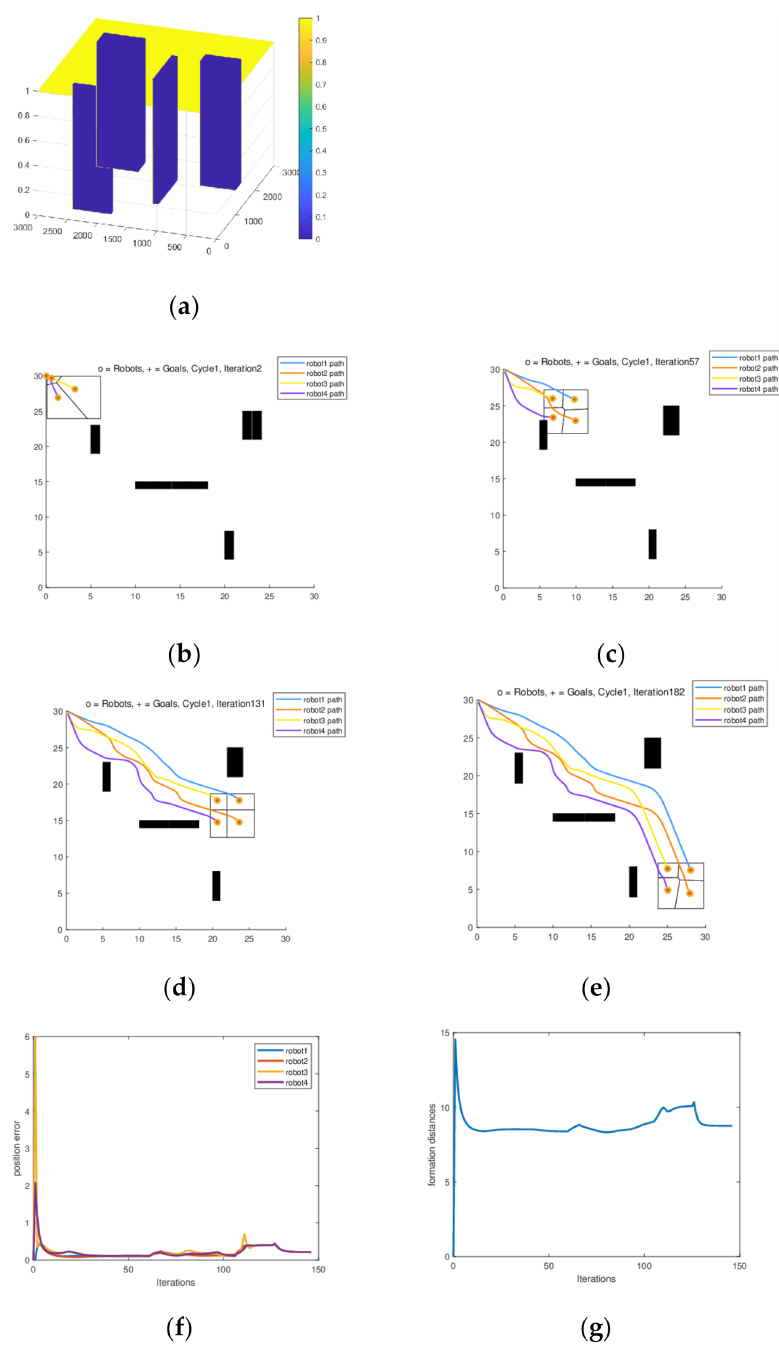
Figure 9. Dynamic formation simulation under random obstacle scenario: ( a ) distribution of density function under random obstacle scenario; ( b ) k = 2; ( c ) k = 57; ( d ) k = 31; ( e ) k = 182; ( f ) position error; ( g ) formation preservation